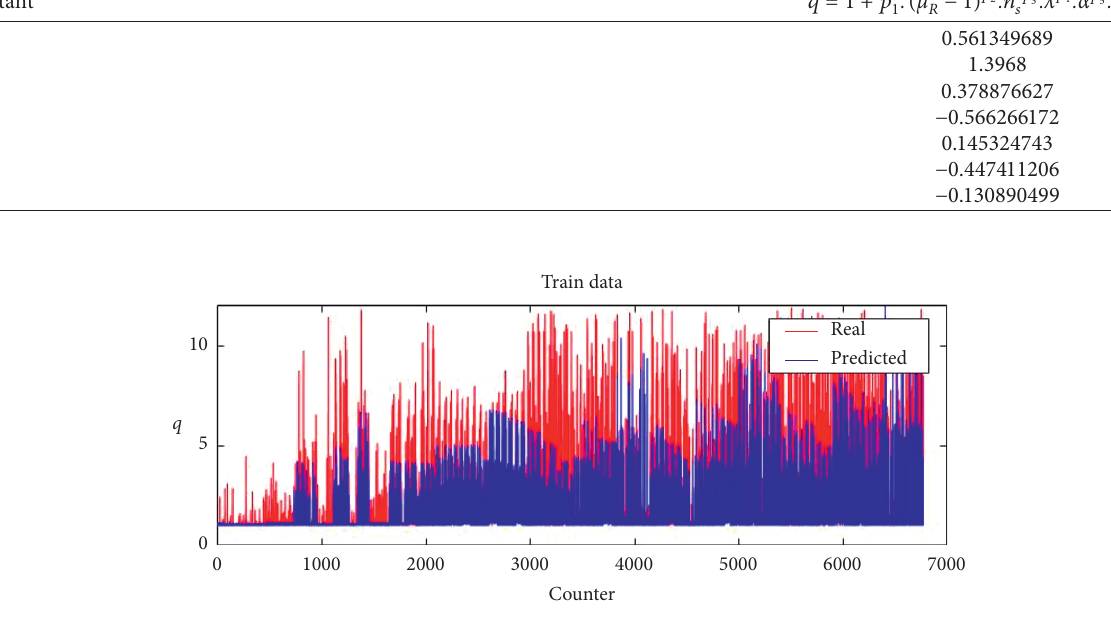
Figure 8: Real and predicted q from predicted correlation (training data).